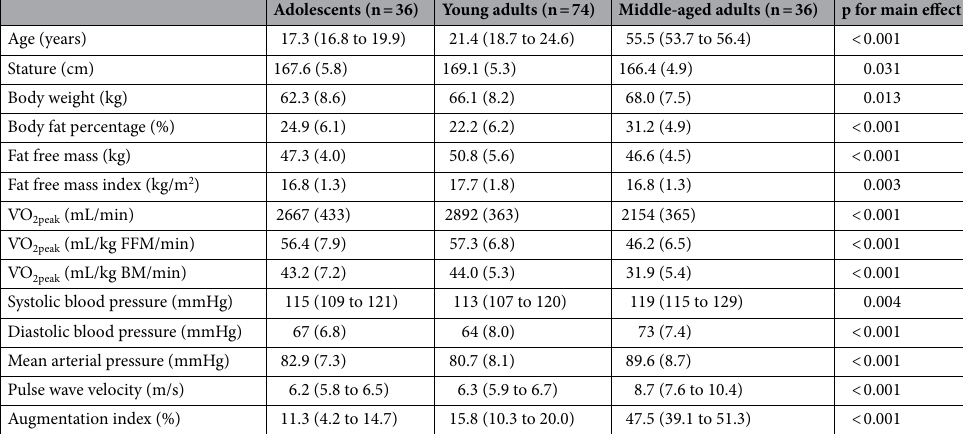
Table 1. Descriptive characteristics among the study samples. The data are mean (standard deviation) or median (interquartile range). The p-values are from the one-way analysis of variance or Mann–Whitney U-test.